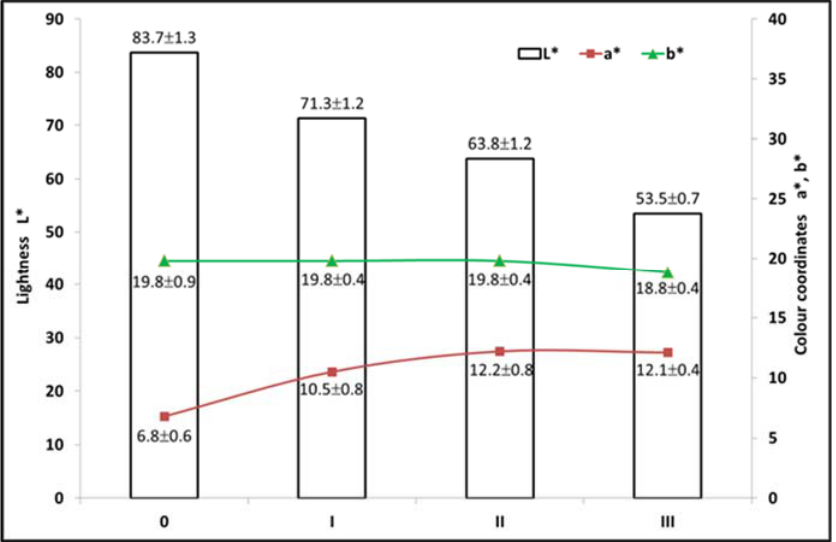
Figure 9. Colour coordinates L*, a* and b* according to steaming